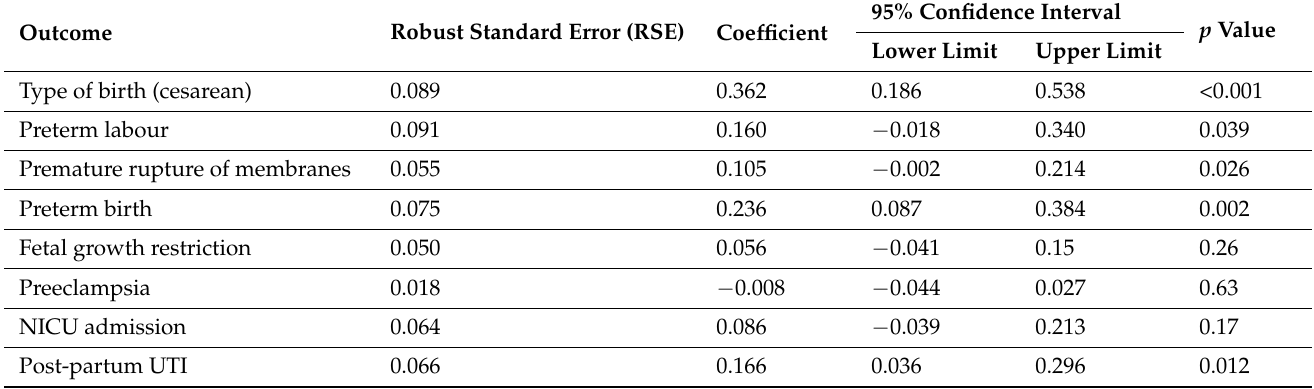
Table 2. Results from the propensity score match